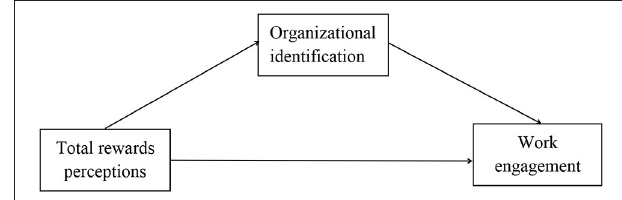
FIGURE 1 | Hypothesized model.